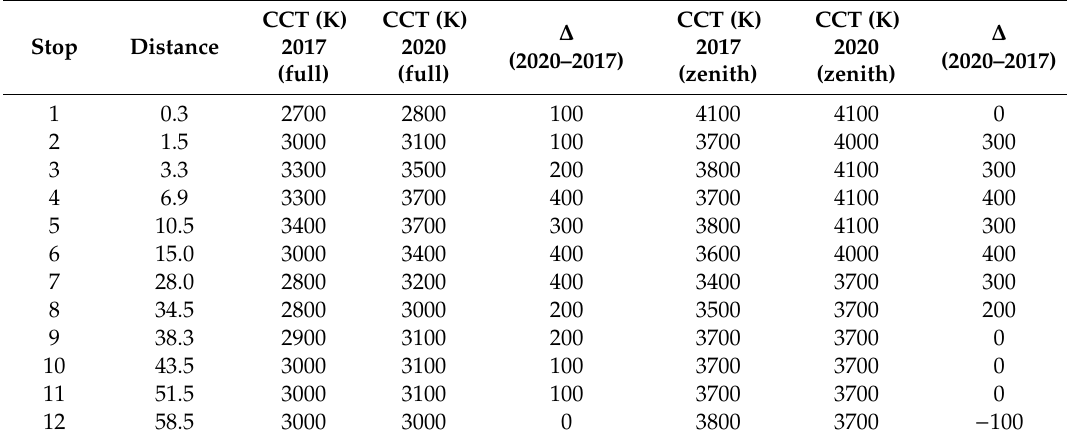
Figure 6. Correlated color temperature (CCT) for all-sky and at zenith at different distances from the city center of Berlin, Germany, measured during a clear night in 2017 (black solid circles and triangles) and a clear night during the COVID-19 lockdown in 2020 (grey diamonds and squares). Table 4. List of all CCTs for the full image and zenith including the difference in CCTs.